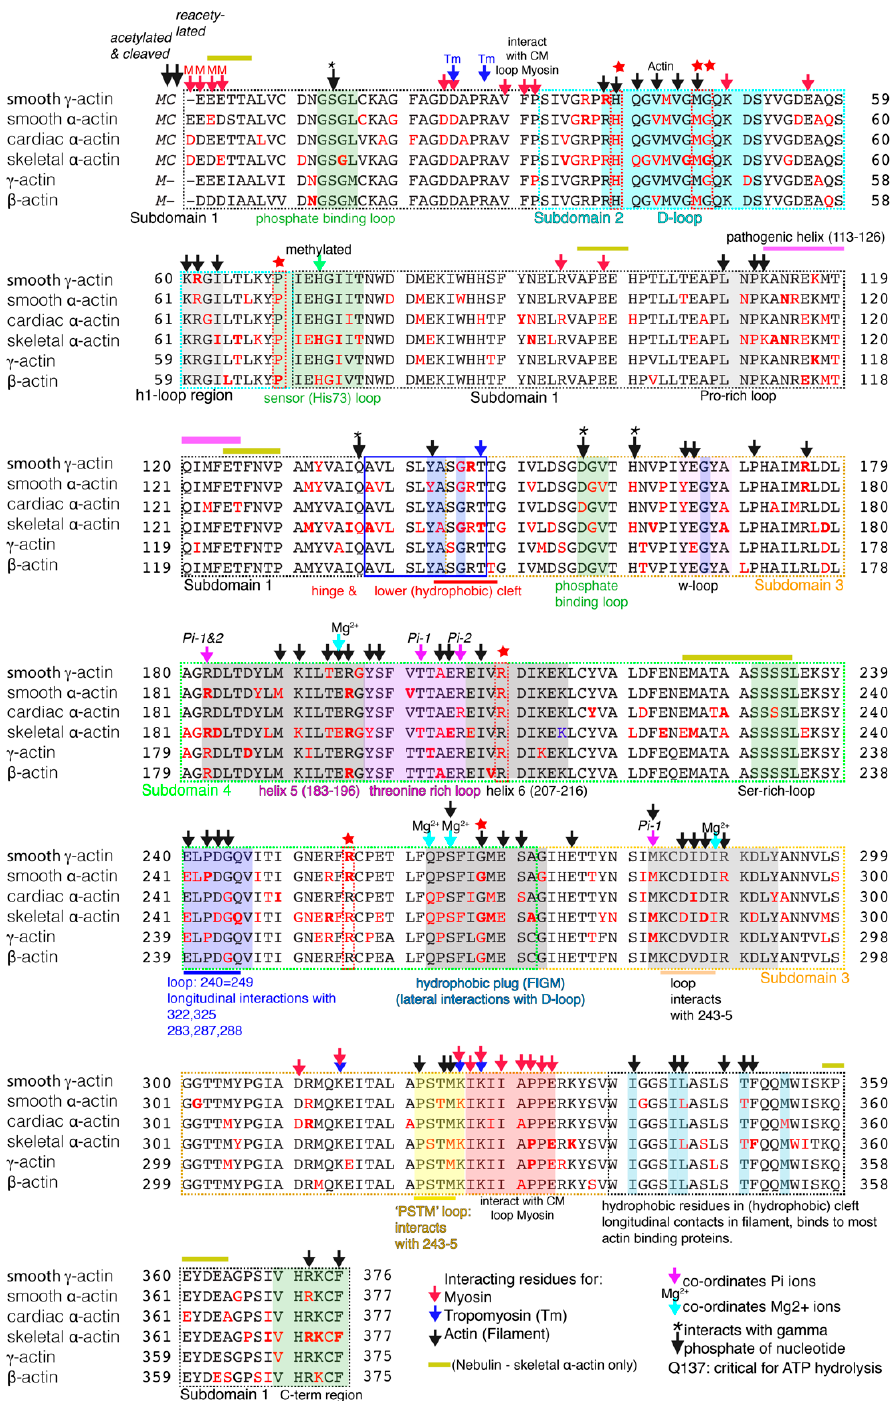
Figure 1. Annotated alignment of the six actin sequences for Homo Sapiens showing the positions of mutations. All six sequences were retrieved from UNIPROT (P63267: smooth γ -actin, P60709: β -actin: P68133: skeletal α -actin, P63261: γ -actin; P60382: cardiac α -actin, P62736: smooth α -actin). The first one–two residues are typically acetylated and cleaved, such that the third residue is the first residue in the expressed sequence. The positions of key interaction regions in the sequences is indicated together with positions of mutated residues (red font) in each sequence. Residues in which mutations are found in four out of the six isoforms are indicated by a red star. See text for more details. Numbering in the text refers to the residue number for α -actin isoforms. Mutations were retrieved from the Human Genome Mutation Database (HGMD).